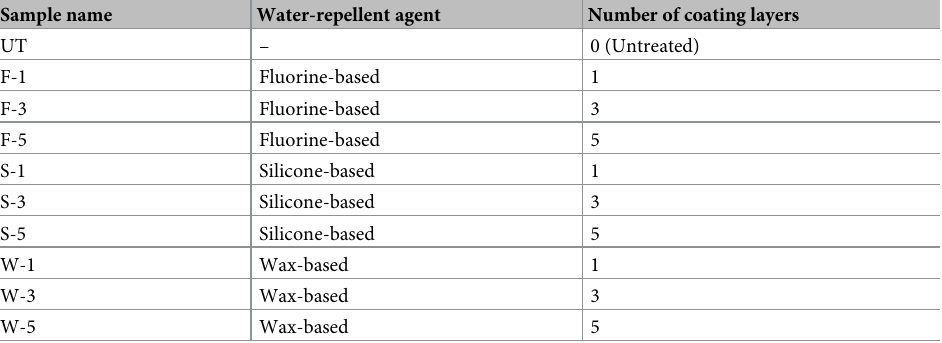
Table 2. Samples prepared for the evaluation of the physical